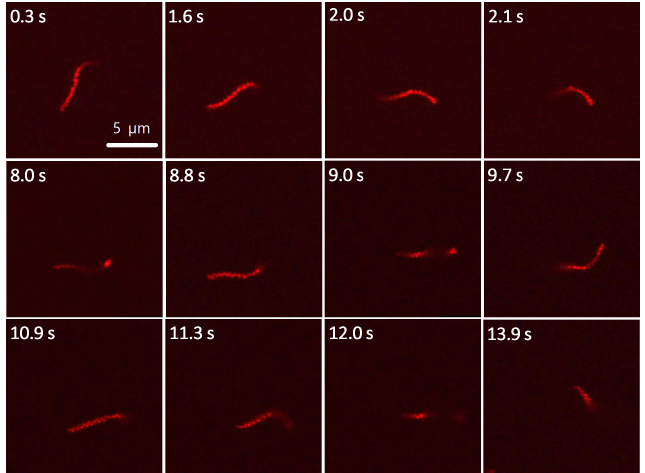
Figure 2. Freely moving Poly(N-vinylcaprolactam) (PVCL)/acetoacetoxyethyl methacrylate (AAEM) microgel chain (with adsorbed rhodamine B) observed by confocal fluorescence microscopy.